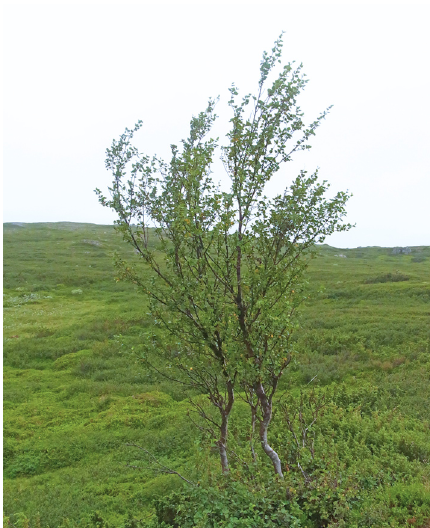
Figure 4: The nearest treeline of birch (2010) is located 7 km east of Helagsglaciären. Since the early 20th century it has shifted upslope by 75 m.